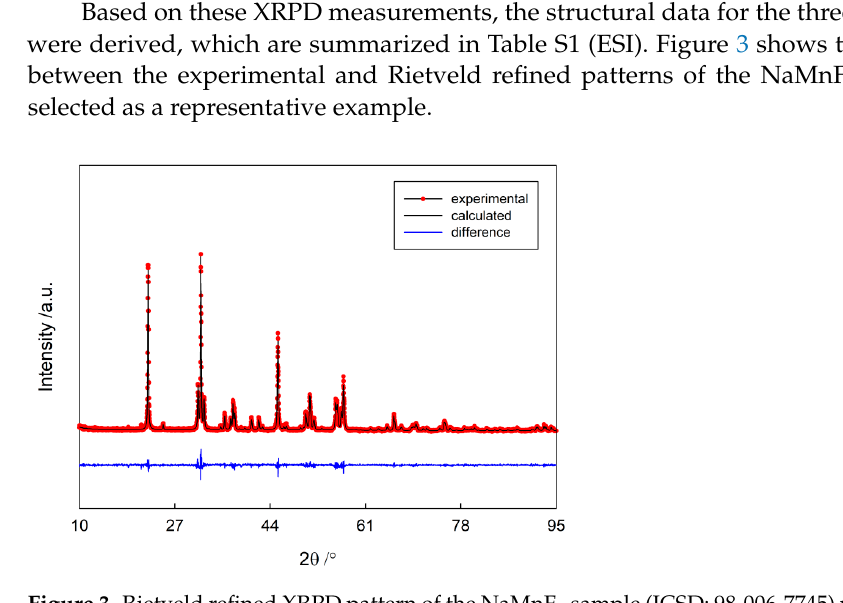
Figure 3. Rietveld refined XRPD pattern of the NaMnF 3 sample (ICSD: 98-006-7745) prepared without sodium citrate ( χ 2 = 1.37). sodium citrate ( χ 2 =